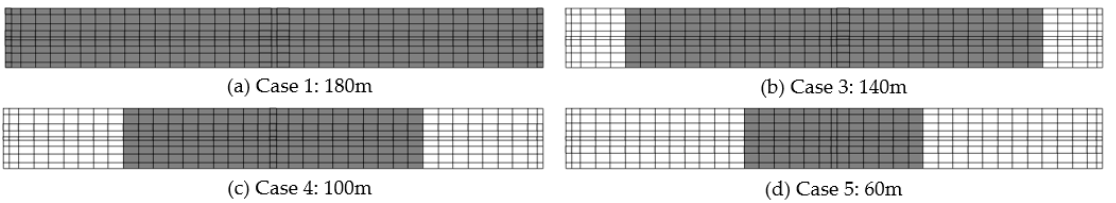
Figure 16. Four fracture profiles with different lengths of propped fracture (gray: propped; white: unpropped).